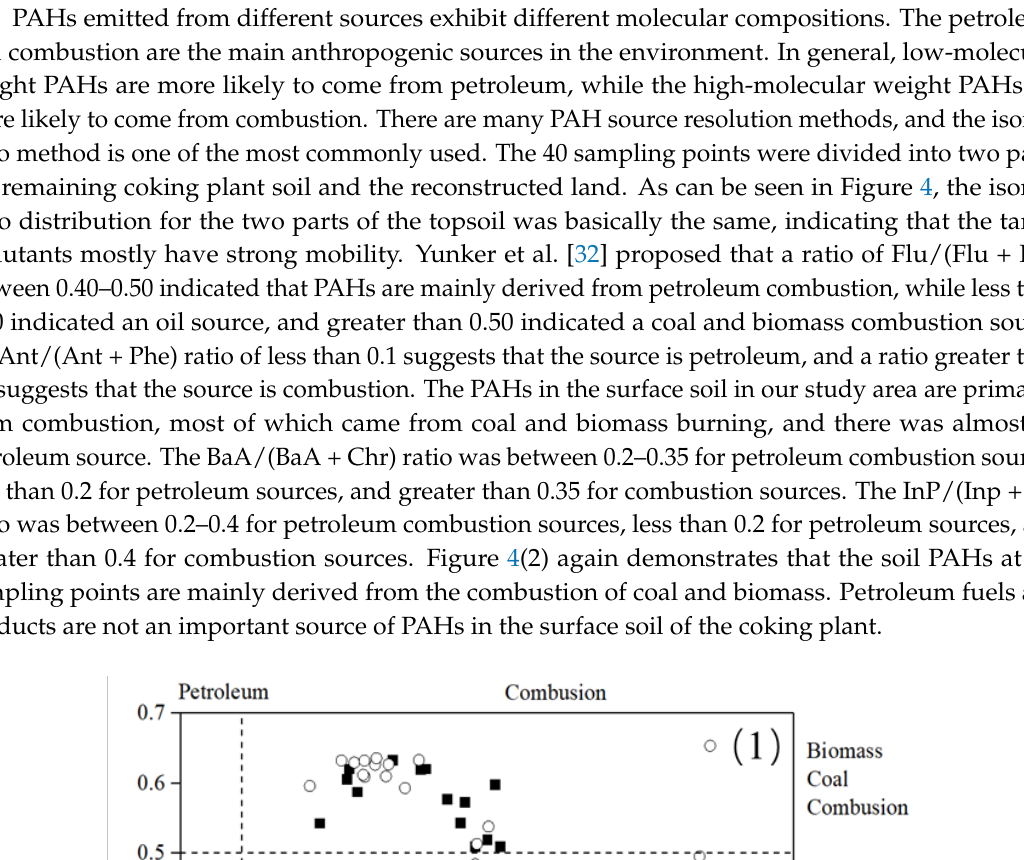
Figure 4. Cross-plots for the individual PAH ratios in the reconstructed land and previous coking plant: ( 1 ) Ant/(Ant + Phe) versus Flu/(Flu + Pyr) and ( 2 ) BaA/(BaA + Chr) versus InP/(Inp + BP). 3.2.2. Principal Component Analysis Principal component analysis (PCA) is a multivariate statistical method that uses multiple variables to linearly transform and select fewer significant variables. In this study, 16 factors were selected, including Nap, Acy, Ace, Fl, Phe, Ant, Flu, Pyr, BaA, Chr, BbF, BkF, BaF, InP, DBA, and BP. Through KMO (Kaiser–Meyer–Olkin) and Sig (Significance) tests, we concluded that the KMO value reached 0.85 and the SIG was 0, which indicates that the data were taken from the normal distribution, the correlation between variables was recognized, and the data were suitable for factor analysis. The PCA results showed that 82.56% of the total difference was calculated from the first three main factors. PC1 accounted for 57.45% of the total variance, and was dominated by Flu, Byr, Chr, BbF, BaA, and InP (Figure 5a). In this group, the load for Flu and Pyr was significantly higher than that of other compounds, which are indicators of coal combustion [33]. PC2 accounts for 14.52% of the total variance, and was characterized by Nap, which typically represents atmospheric transmission [34],